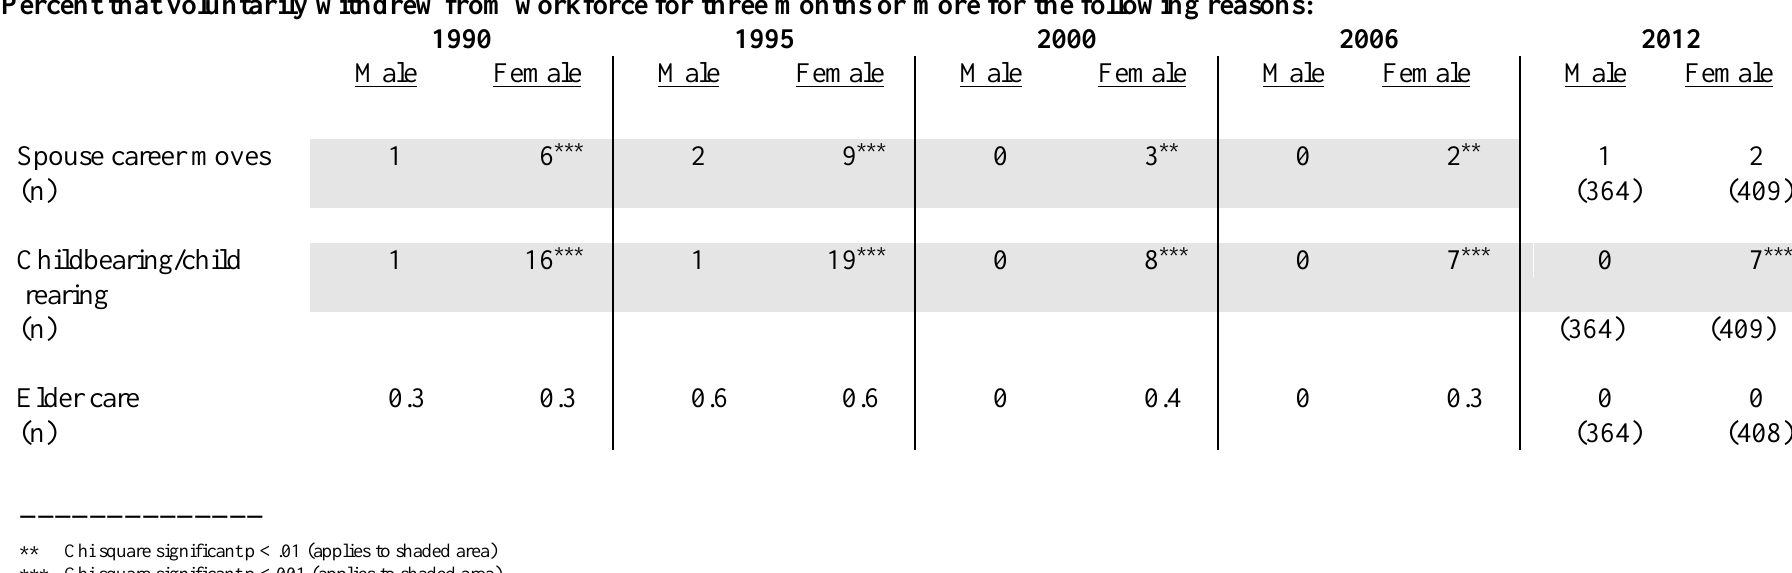
Table 21. Voluntary Slowing of Career